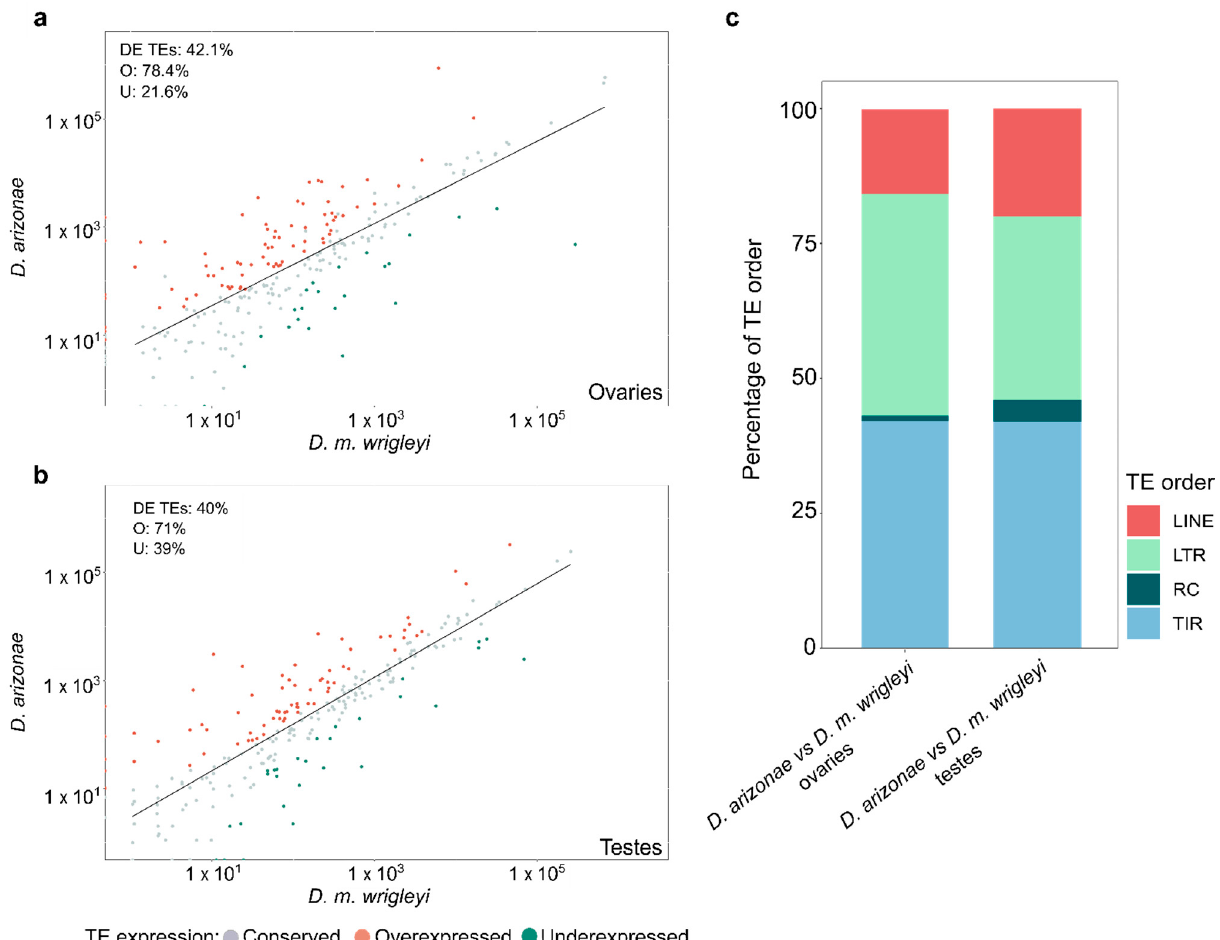
Figure 1. Expression profile of TEs in gonads of D. arizonae compared with D. m. wrigleyi subspecies. Scatter plots representing differential TE expression in ( a ) ovaries and ( b ) testes between D. arizonae and D. m. wrigleyi. TE families were considered as DE when they presented Log2(FoldChange) ≥ |1| and p -value adjusted (corrected by FDR) < 0.01. ( c ) Percentage of DE TEs families between parental lines classified by TE order. Transposable elements from TIR and RC orders belong to Class II elements, known as DNA transposons. Transposable elements from LTR (long terminal repeat) and LINE (long interspersed nuclear element) orders belong to Class I elements, known as retrotransposons. DE TEs: deregulated TEs; O: overexpressed TEs; U: underexpressed TEs.